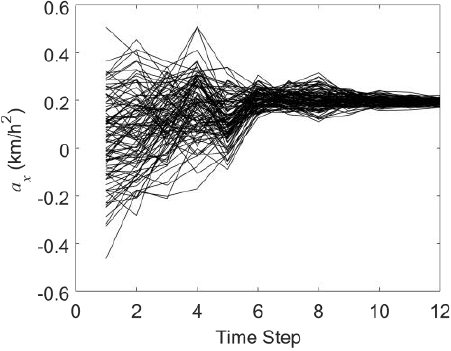
Figure 6. The history matching results of the velocity in the Y-direction ( V y ).